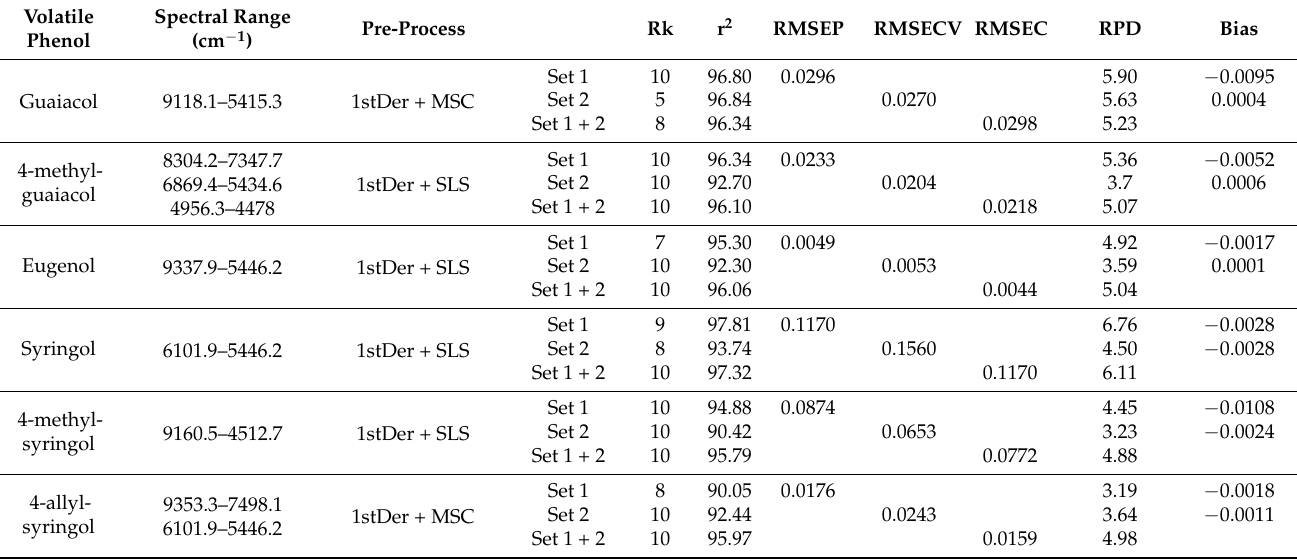
Table 3. Cross-validation and validation set results of the calculated models obtained for different